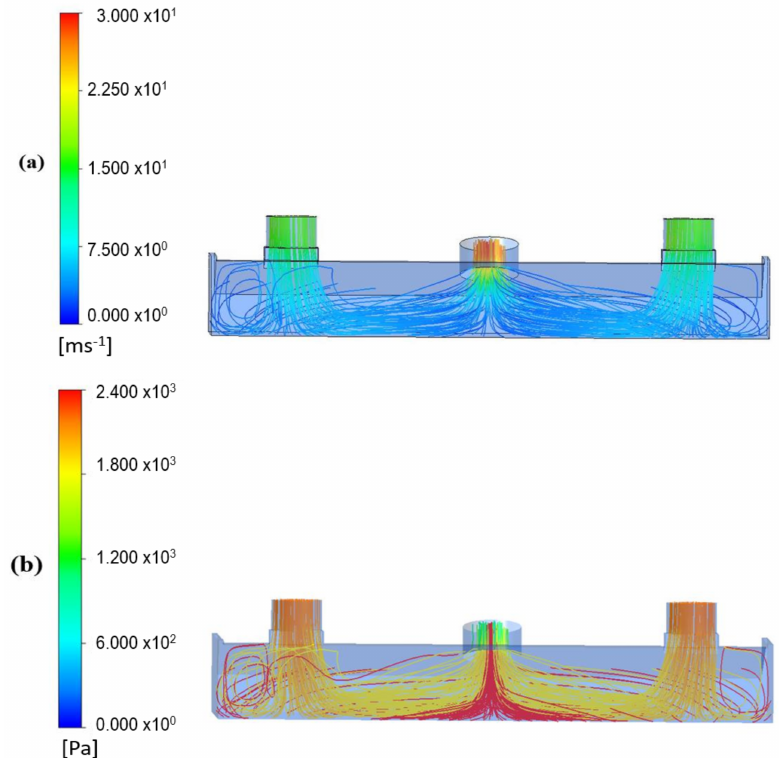
Figure 6. The velocity and trajectory of the secondary airflow through the inlet and suction port of the pickup head: ( a ) velocity contour; ( b ) pressure